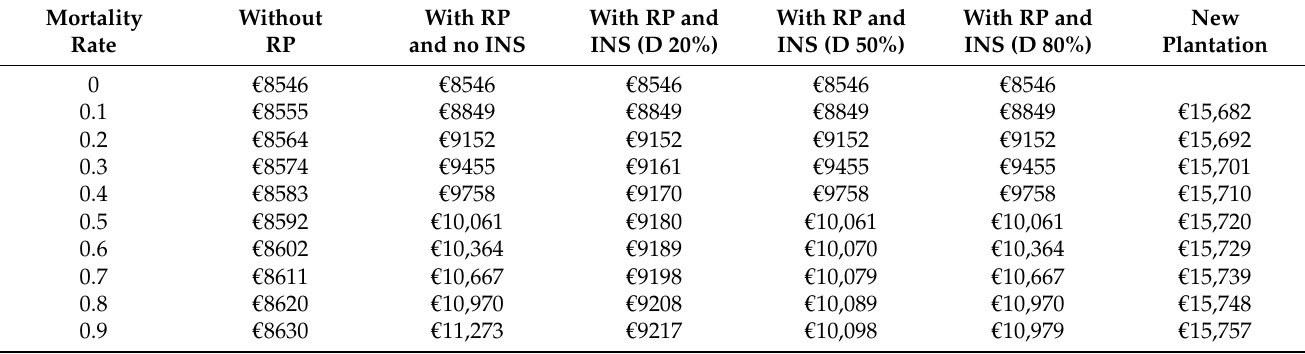
Table A3. Total discounted costs of the forest owner in EUR/ha for sessile oak ( Quercus petraea Liebl.) (itinerary “SO_CS-IP+F”) considering no replantation after drought shock (“Without RP”), replantation without insurance by the forestry company (“With RP and no INS”), replantation with insurance by the forestry company (“With RP and INS”) with three deductibles (“D 20%”, “D 50%”, “D 80%”), and full replanting (“New plantation”), for different mortality